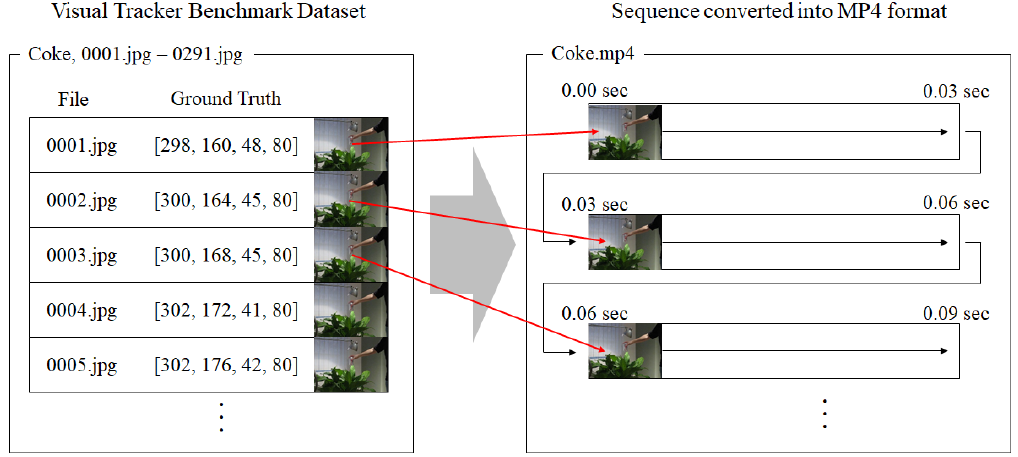
Figure 7. Dataset conversion into movie clip of mp4 format.